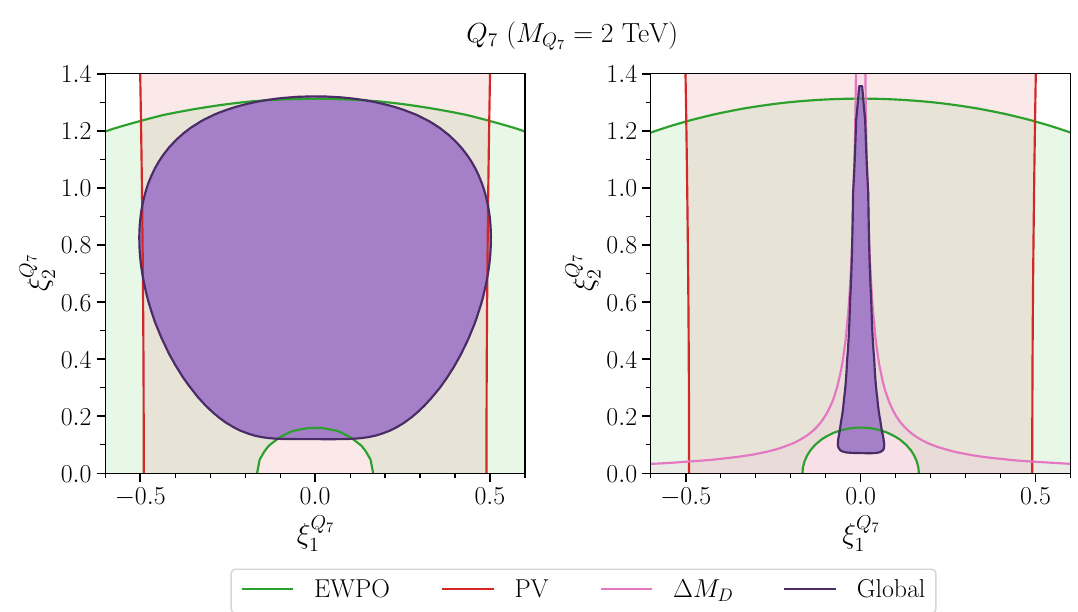
Figure 11 . Global fit to 1 st and 2 st generation couplings of the VLQ Q 7 . The left-hand side assumes multiple generations of VLQs, each only coupling to a single generation (i.e. effectively removing constraints from kaon physics), while on the right side this assumption is removed. are smaller than in case of the SU(2) L singlet VLQs, and so the corresponding bounds cannot be seen in our region shown. Once we allow the triplet to couple to both generations at once, D 0 – D 0 mixing becomes stronger and kaon constraints are extremely tight. T (figure 2